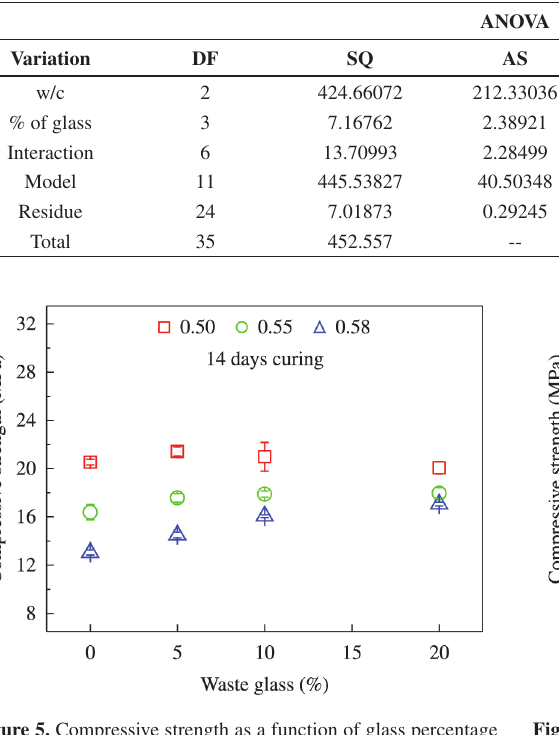
Figure 5. Compressive strength as a function of glass percentage after 14 days of curing.